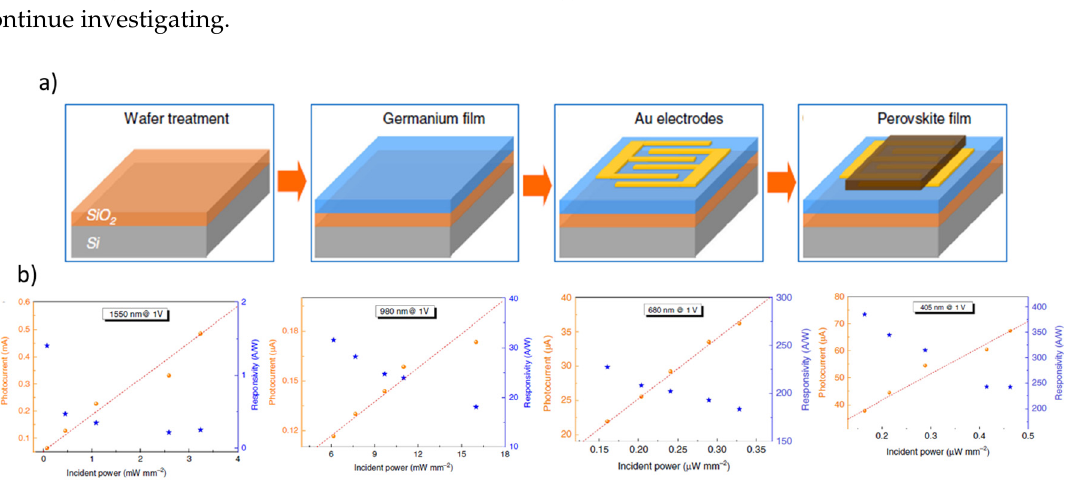
Figure 3. ( a ) Schematic illustration of the germanium / perovskite heterojunction device fabrication process. From left to right: a cleaned SiO 2 / Si substrate, growth of a germanium layer by molecular beam epitaxy (MBE), Au electrode deposition on the substrate, perovskite layer construction by the vapor-solution method. ( b ) I ph and R values under an illumination wavelength of 1550 nm, 980 nm, 680 nm and 405 nm, from left to right, respectively (adapted from [69]).